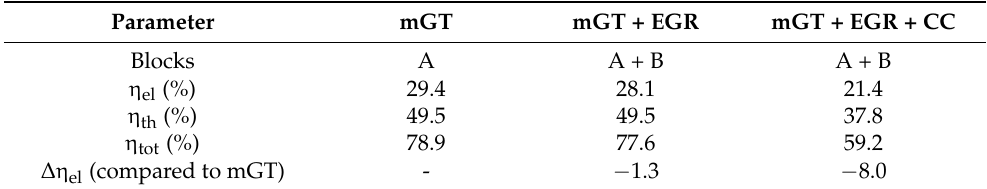
Table 8. Comparison of the electrical efficiencies for various plant layouts functioning in CHP mode (adapted from [78]).